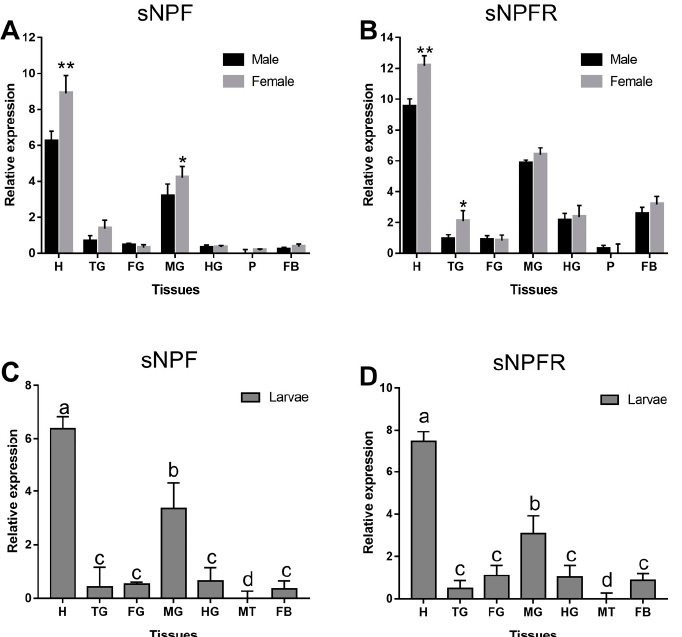
Figure 4. Relative expression levels of emerged adults of sNPF ( A ) and sNPFR ( B ), and larvae of sNPF ( C ) and sNPFR ( D ) in different body parts of D. armandi . The relative expression levels were normalized with β -actin and CYP4G55 . Different lowercase letters indicate significant differences at the 0.05 level. The asterisk indicates a significant difference between female and male expression levels (* p < 0.05, ** p < 0.01, independent Student’s t -test). All values are mean ± SE, n = 3. H, head; TG, thoracic ganglion; FG, foregut; MG, midgut; HG, hindgut; P, pheromone gland; MT, Malpighian tubule; FB, fat